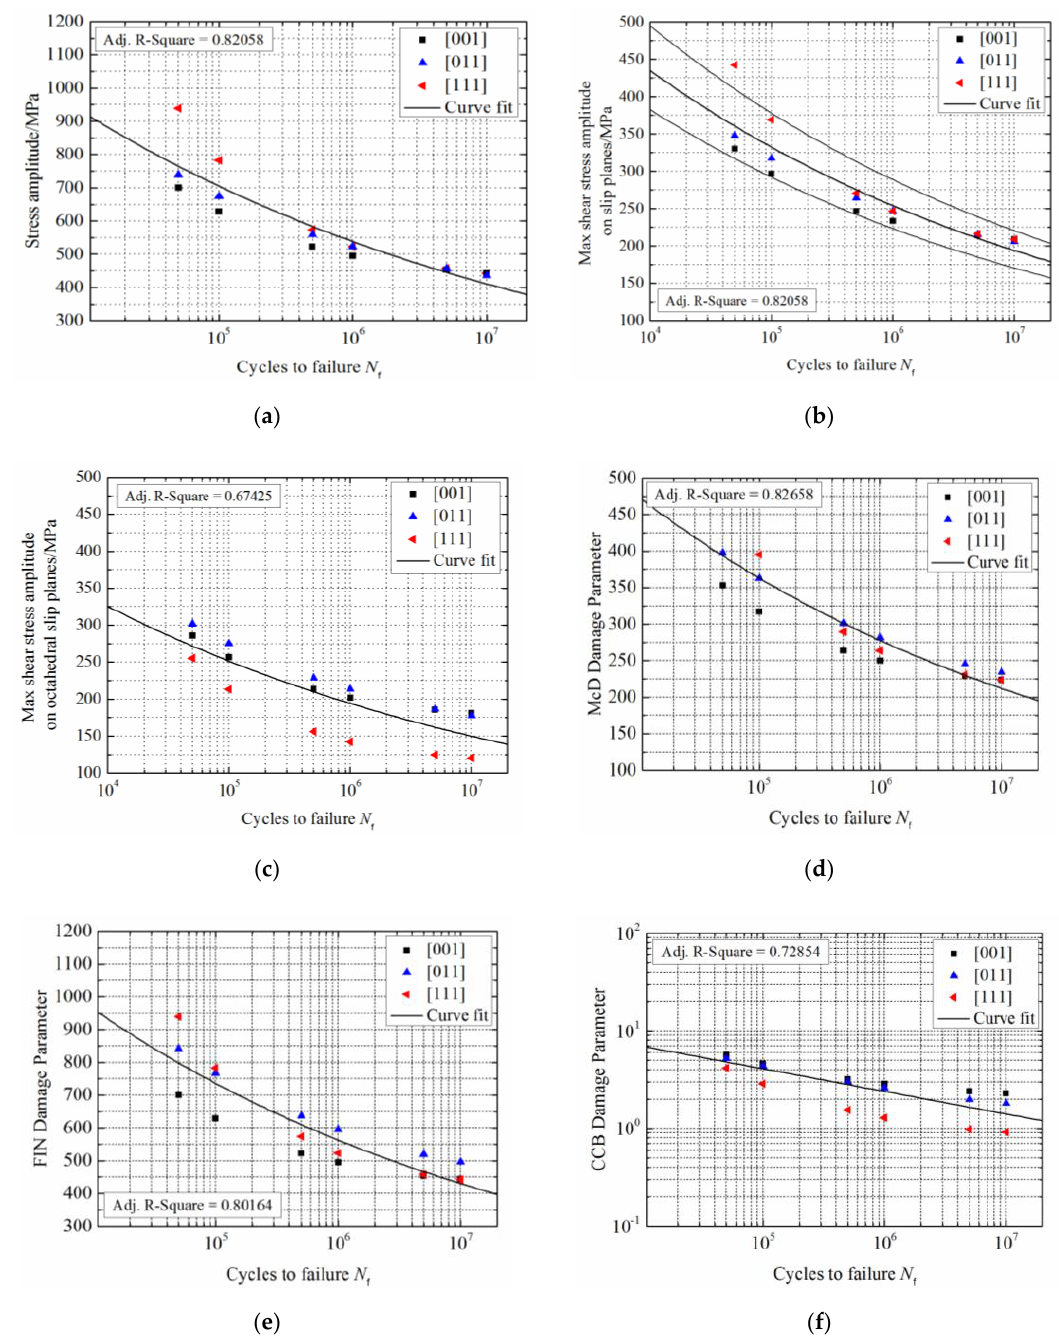
Figure 2. Fatigue life predictions for DD6 material at 700 °C: ( a ) stress amplitude; ( b ) maximum resolved shear stress amplitude; ( c ) maximum resolved shear stress amplitude (primary octahedral slip system); ( d ) McD model; ( e ) Fin model; ( f ) CCB model.